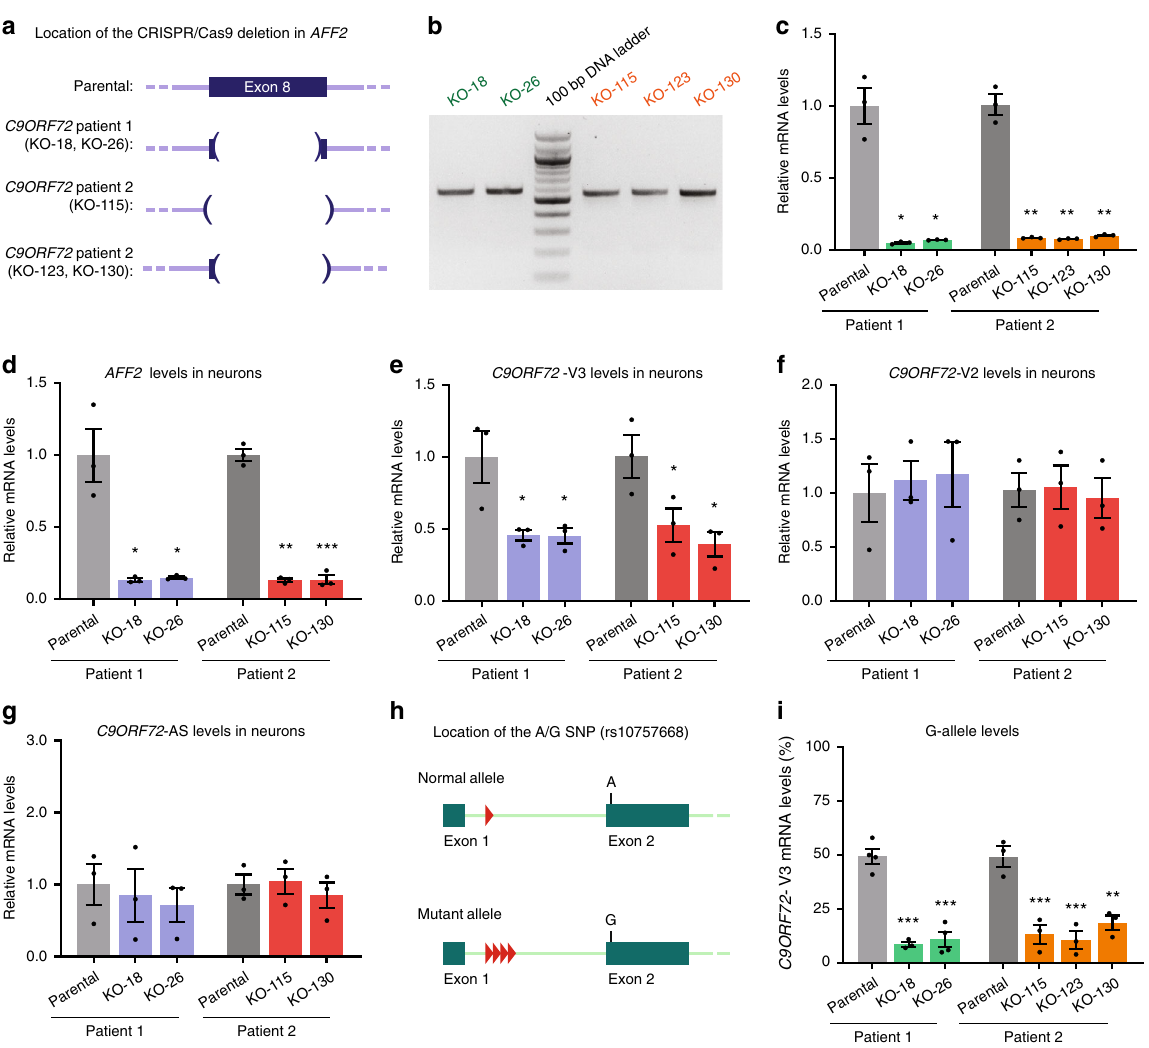
Fig. 7 AFF2 regulates expression of expanded G 4 C 2 repeats. a Schematic of the CRISPR-Cas9-mediated deletions created in exon 8 of AFF2 to generate AFF2 knockout (KO) C9ORF72 iPSC lines. b PCR ampli fi cation of the genomic region containing exon 8, showing that all lines were homozygous for the deletion. c AFF2 mRNA levels in parental and AFF2 -KO iPSC lines. Neurons from CRISPR-Cas9-edited lines were analyzed for expression of AFF2 ( d ), C9ORF72 -V3 ( e ), C9ORF72 -V2 ( f ), and C9ORF72 antisense ( g ) mRNAs. h Schematic of the location of the A/G SNP (rs10757668) in exon 2 of C9ORF72 . i Pyrosequencing quanti fi cation of the relative expression levels of the allele containing expanded G 4 C 2 repeats (G-allele) in parental and AFF2 -KO iPSC lines. Each data point represents one differentiation ( n = 3 independent differentiations). Values are mean ± s.e.m. * p < 0.05; ** p < 0.01; *** p < 0.001 ( c , d , Welch ’ s t test; e , i , one-way ANOVA, Dunnett ’ s multiple comparisons test). Source data are provided as a Source Data fi le.